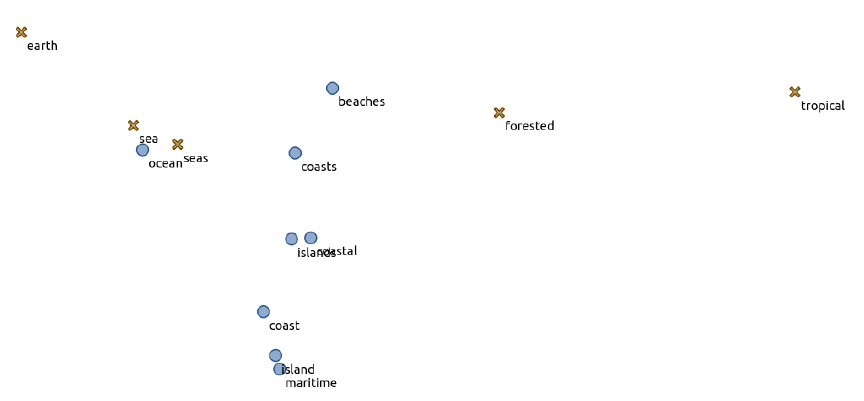
Figure 13. A zoom-in of a t-SNE plot to exemplify the separation of words into sensory and non- sensory despite their similarity of word embeddings. This shows that some words can hold a form of similarity but are not deemed “equal” in a descriptive sensory sense.